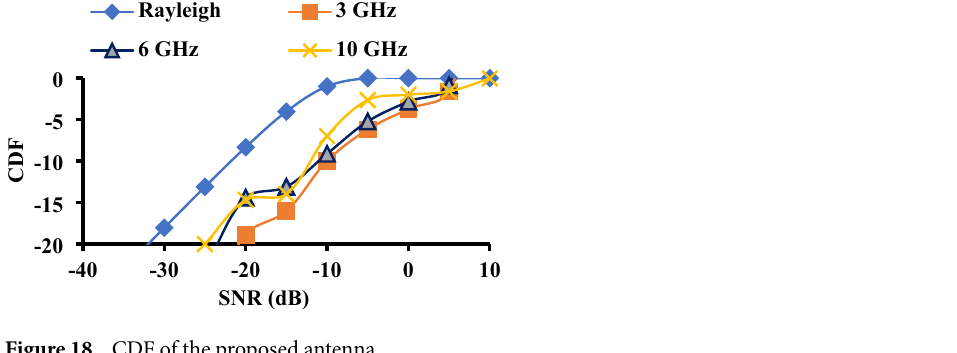
Figure 18. CDF of the proposed